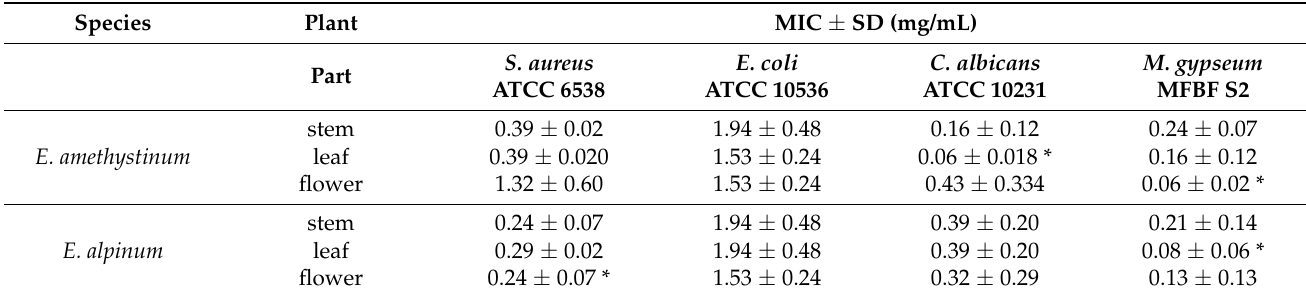
Table 4. Antimicrobial activity of methanolic extracts obtained from Eryngium alpinum and E. amethystinum . Presented values denote means ± SD. N =